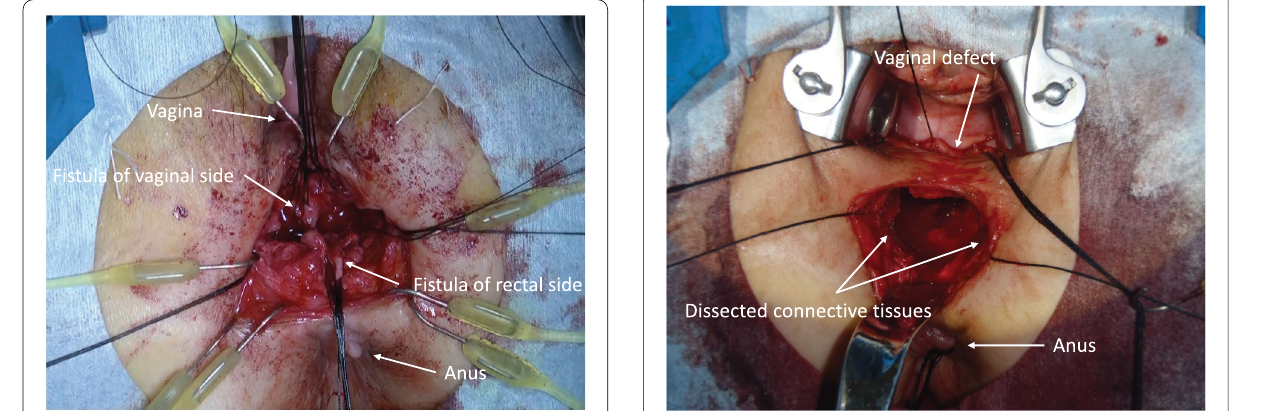
Fig. 5 After the complete resection of the previous anastomosis and RVF, dissected connective tissues were